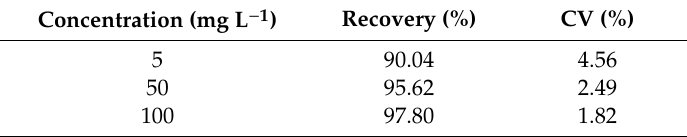
Table 1. Recovery of thiocyanate and its coe ffi cient of variation